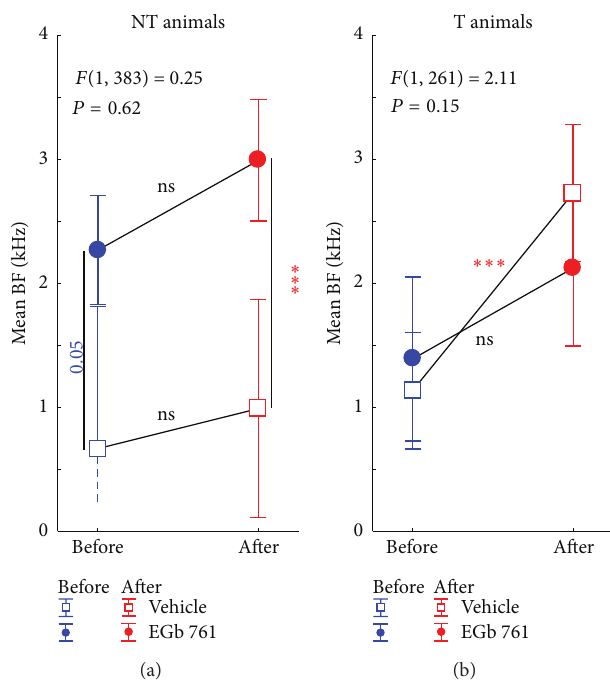
Figure 8: Effect of noise trauma on mean best frequency (BF) ± 95% confidence interval in NT and T animals. Depicted are the statistical interactions of time of measurement (before versus after trauma) and animal group (V versus E) with the 𝐹 -statistics of the 2-factorial ANOVAs. Asterisks indicate significant Tukey post-hoc-tests levels (ns = not significant, ∗∗∗ 𝑃 < 0.001 ). Note the offset between vehicle and EGb 761 treated animals in the nontinnitus animals’ data